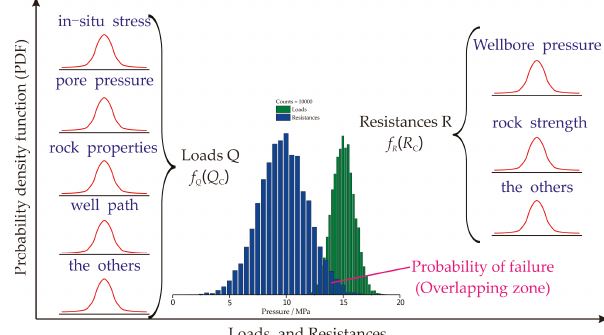
Figure 2. Probability densities for the resistances ( R C ) and loads ( Q C ) of wellbore collapse.